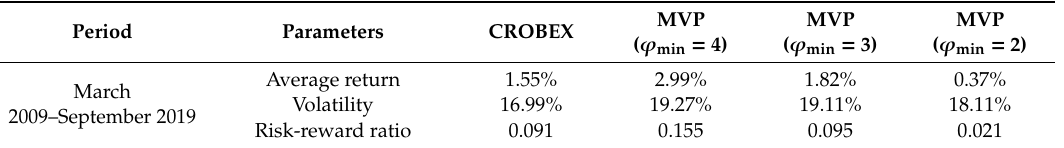
Table 4. Performance of the estimated MVP (using “fundamentally-weighted” returns as inputs for PCA; two factors and di ff erent levels of ϕ on minimum).